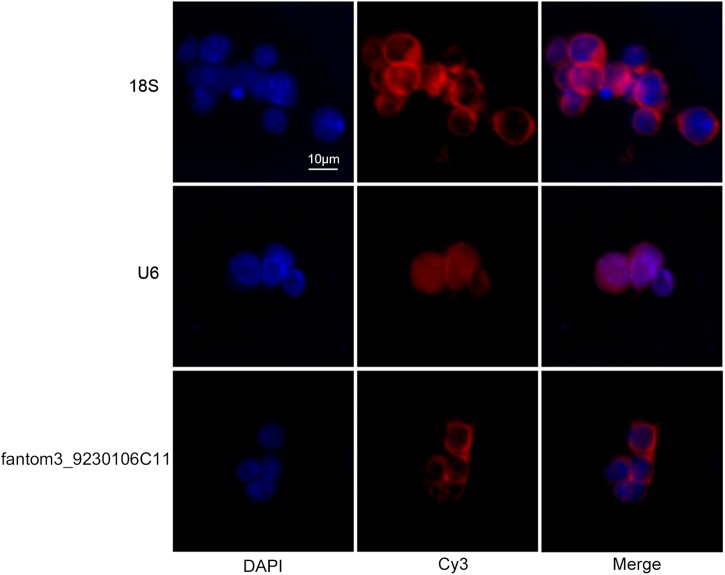
Intracellular location of fantom3_9230106C11 expression in CD4+ T cells by FISH. The nucleus was stained with DAPI, and lncRNA was stained with probe-cyt3. RiboTM U6 and RiboTM 18S were used as reference controls for subcellular localization.